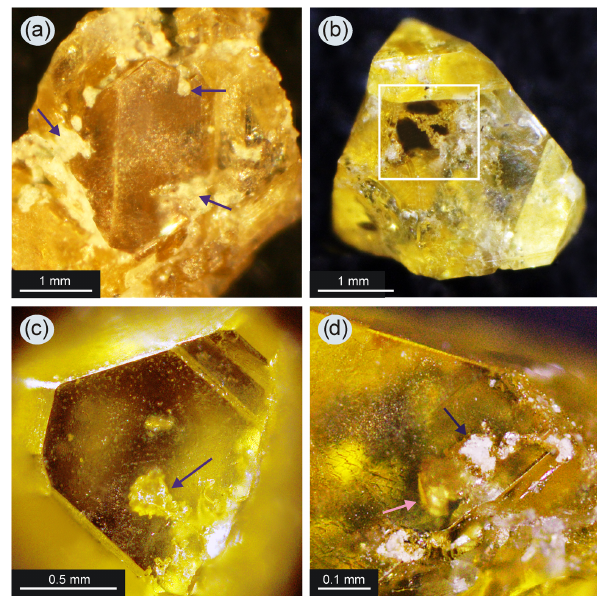
Figure 5. Diamond crystals with silicate inclusions: (a) part of a di- amond crystal from a parallel-growth aggregate (run 2–44) – dark- colored arrows indicate the silicates in the form of fine-grained, light-colored aggregates that are intergrown with the diamond on its surface; silicates also fill the interstices between the diamond in- dividuals; (b) diamond crystal of octahedral habit (run 2–43) – the white square shows a window where the chains of fine-grained sil- icate aggregates are visible inside the crystal; (c) the dark-colored arrow shows the inclusion of silicates of rounded shape consisting of a fine-grained aggregate; the inclusion is located close below the surface of the (111) diamond face (run 2–42); (d) silicate inclusion (shown by the light-colored arrow) that is not completely overgrown by diamond in run 2–42 and has a specific appearance on the surface in the form of cavities filled with light-colored fine-grained material (shown by dark